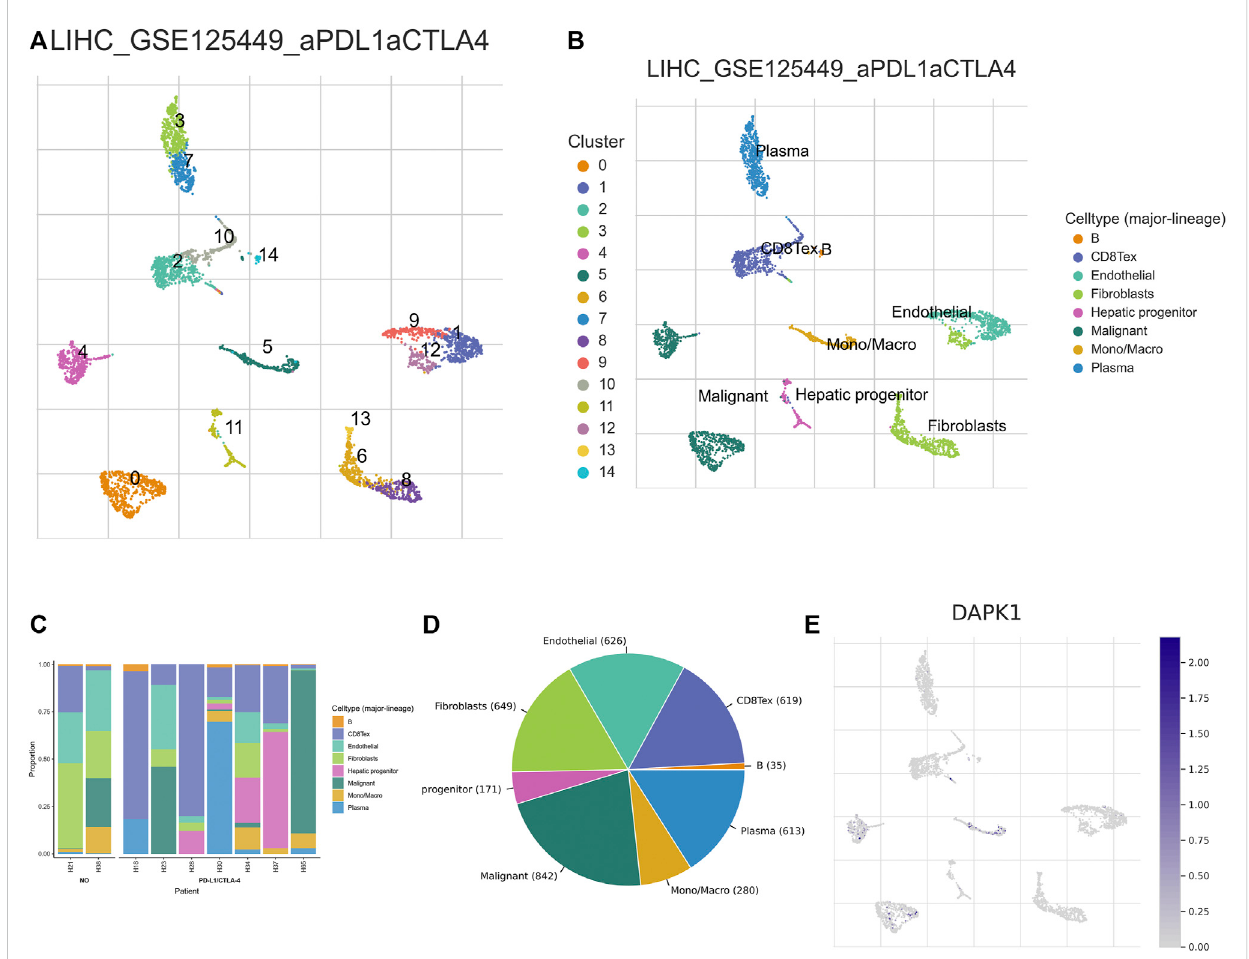
FIGURE 5 Analysis of the expression of DAPK1 in HCC immune microenvironment. (A – D) Annotation of all cell types in LIHC_GSE125449 and the percentage of each cell type. (E) The percents of the expression of DAPK1 in